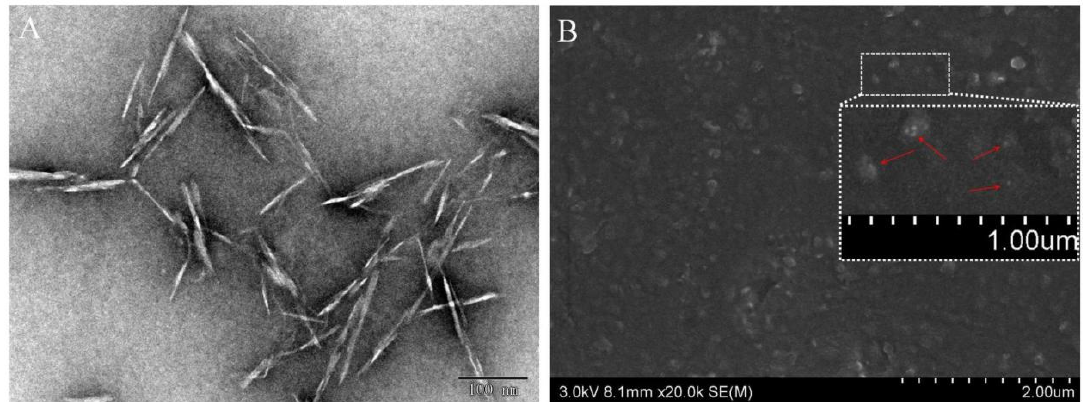
Figure 4. The TEM image of CNCs ( A ) and SEM images of Ag/TA-CNC-PU ( B ).